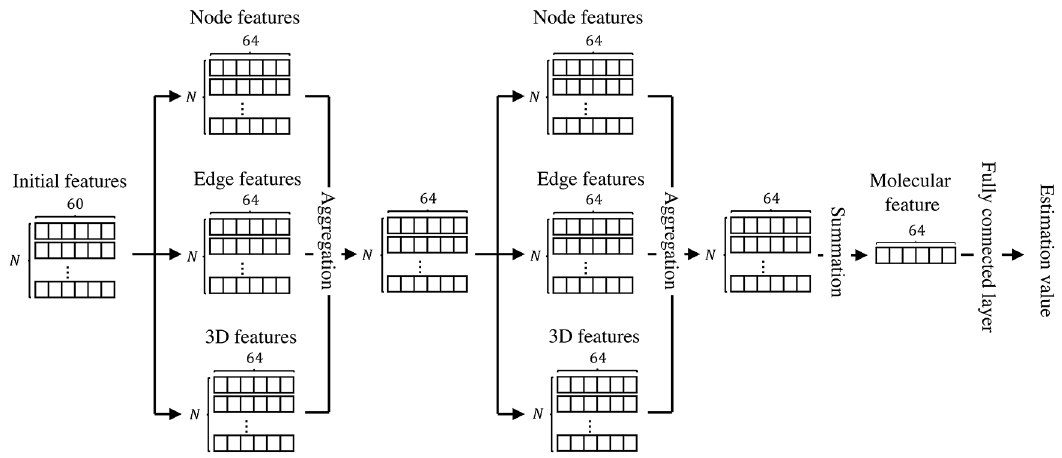
Figure 4. The structure of the model. The initial features are the 60-dimensional